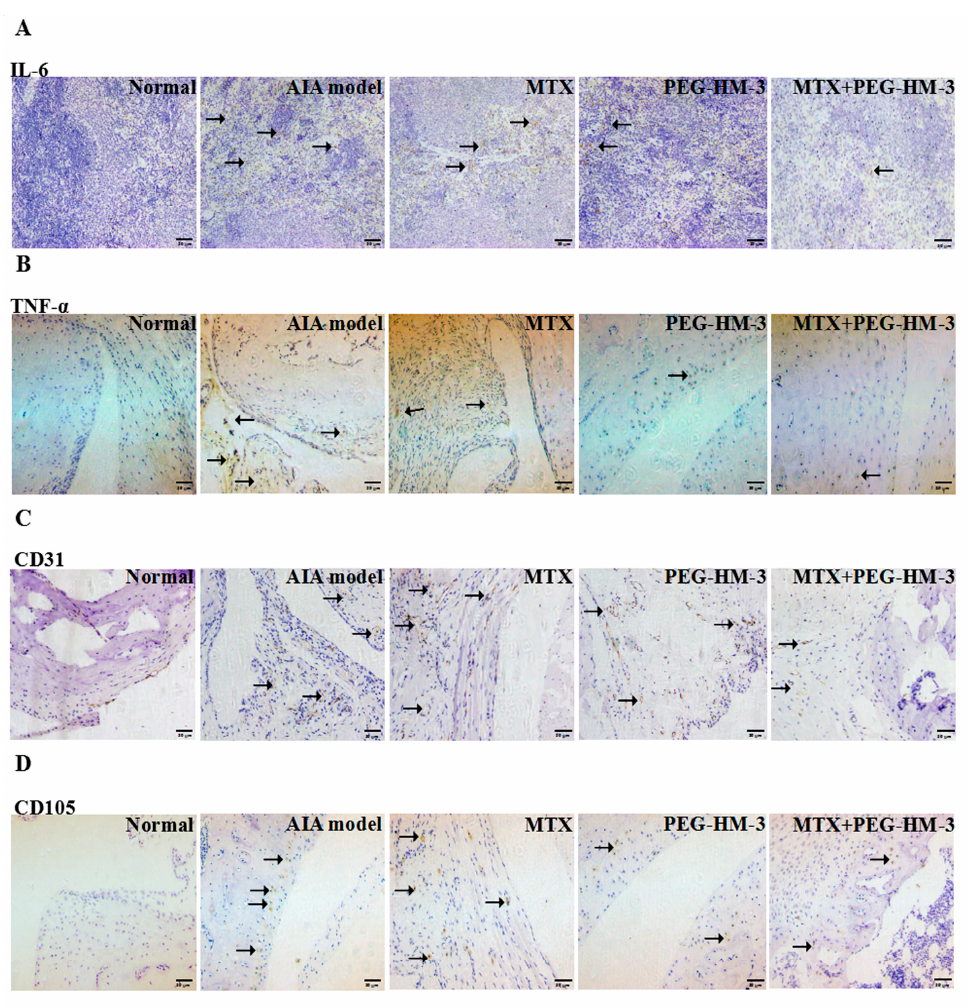
Figure 5. Immunohistochemical analysis in arthritic rats. ( A ) Expressions of IL-6 in spleens; ( B ) Expressions of TNF- α in hind ankles; ( C ) Expressions of CD31 in joint cavity; ( D ) Expressions of CD105 in joint cavity. The positive cells were stained brown and yellow and were indicated with black arrows. Values are means and standard error of the mean (SD) ( A – D ), n = 5–8 in each group, × 200